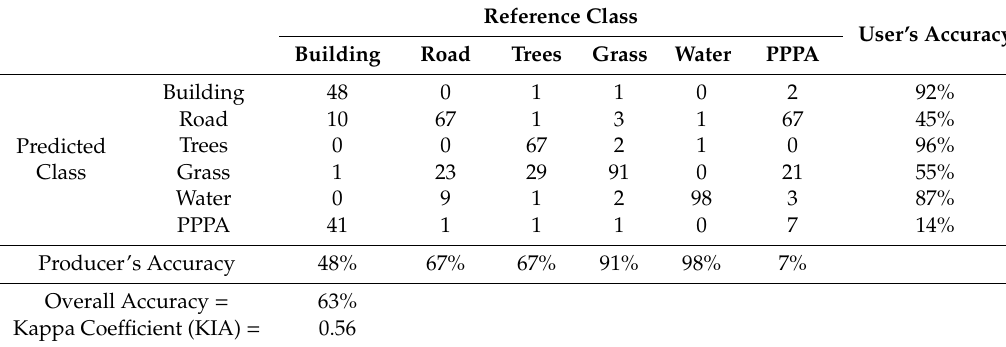
Table 6. Confusion Matrix for classification using Bayesian